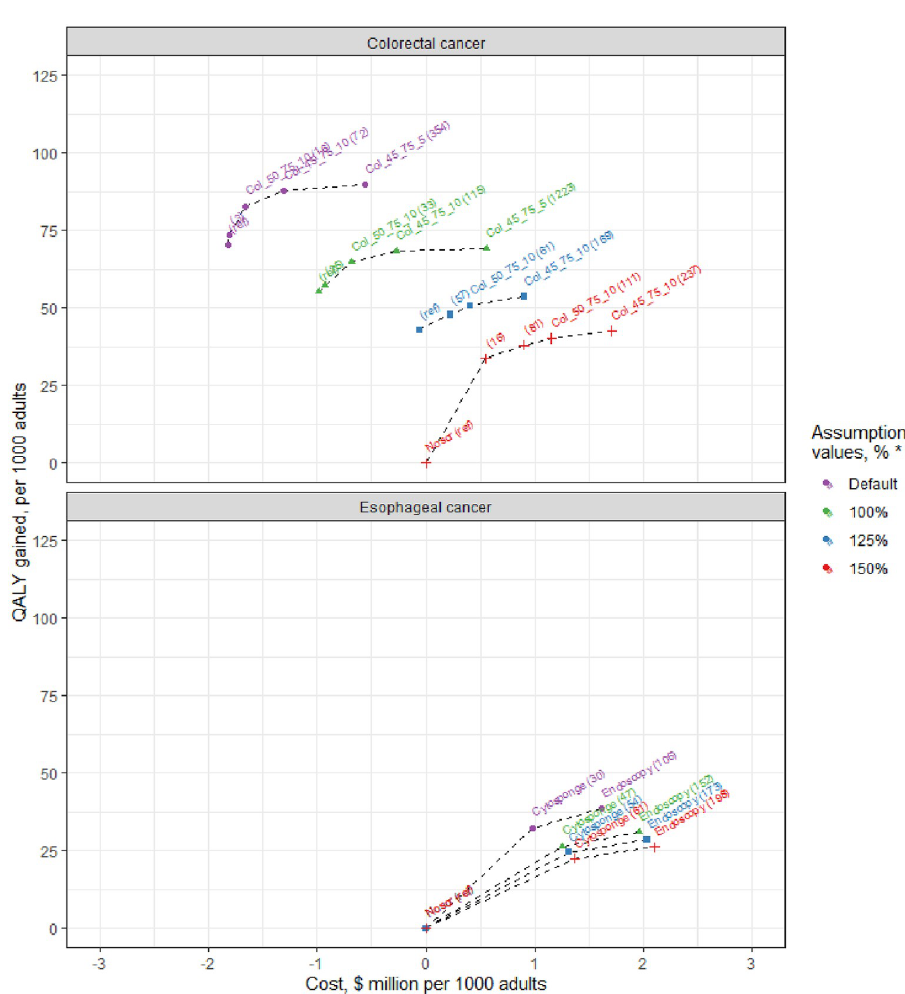
Fig 3. Impact of various assumed values for the future health-related costs, disutility and mortality, on the incremental cost-effectiveness of screening strategies for colorectal cancer and esophageal adenocarcinoma. a a Cost and QALY gained represented costs vs . no screening. The labels show the strategy, and in parentheses the incremental cost-effectiveness ratio ($1000). Assumptions for the health-related costs, disutility and mortality are presented as percentage of the estimated U.S. population averages. The default scenario assumed average mortality, and did not account for health-related costs and disutility.